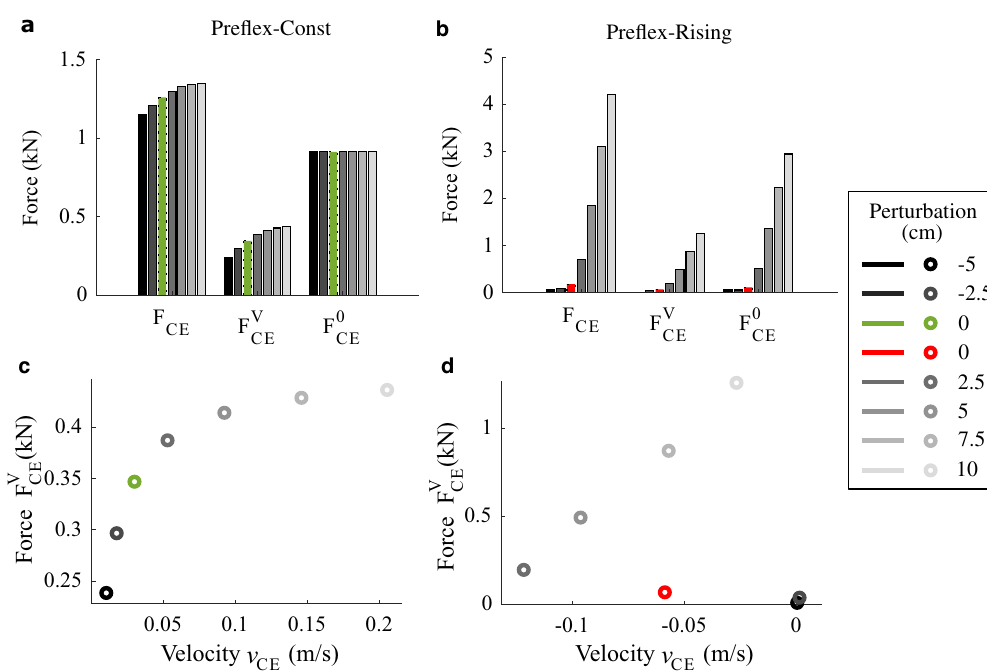
V CE the force component V CE ) on the muscle fibre